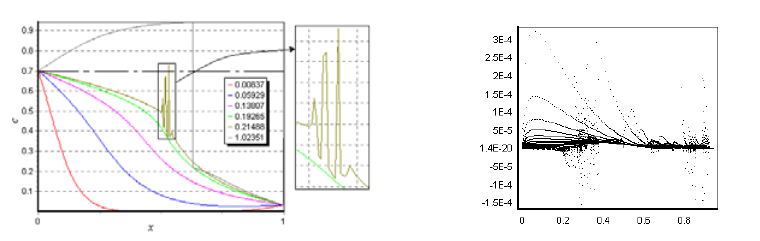
centrationalongx(cid:13)axisatvarious